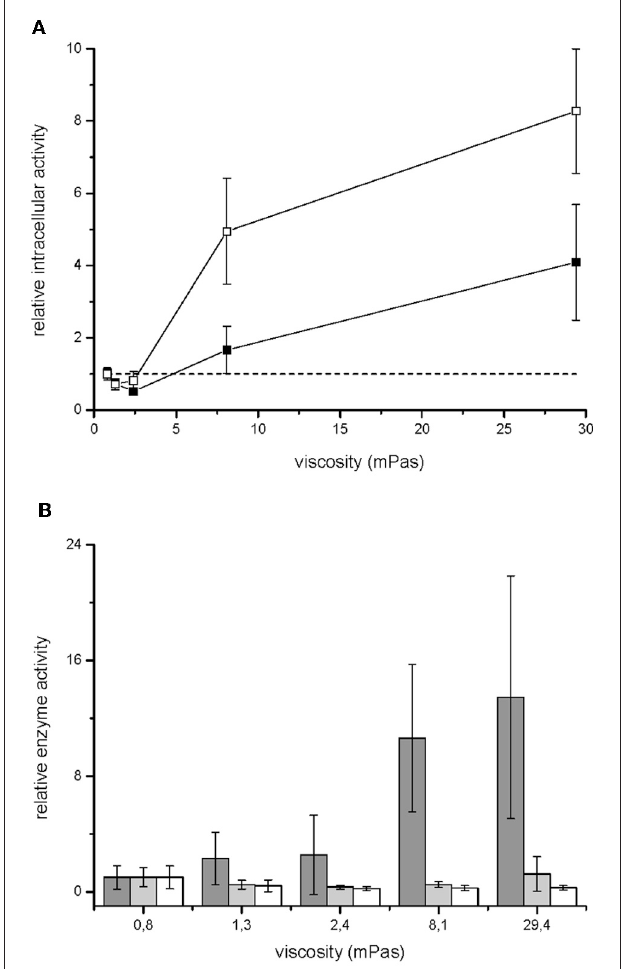
FIGURE 3 | Metabolism of V. ruber grown at different viscosities. Relative respiration rate (open symbols) and dehydrogenaseactivity (filled symbols) of V. ruber are shown in panel (A) . The values presented are means and standard deviations ( n = 5). The dashed line represents metabolic activity in M9 medium. Activities of glucose-6-phosphate dehydrogenase (dark gray columns), phosphofructokinase (light gray columns) and pyruvate kinase (white columns) relative to the basal enzyme activity at 0.8mPas are shown in panel (B) . The values presented are means and standard deviations ( n = 3).